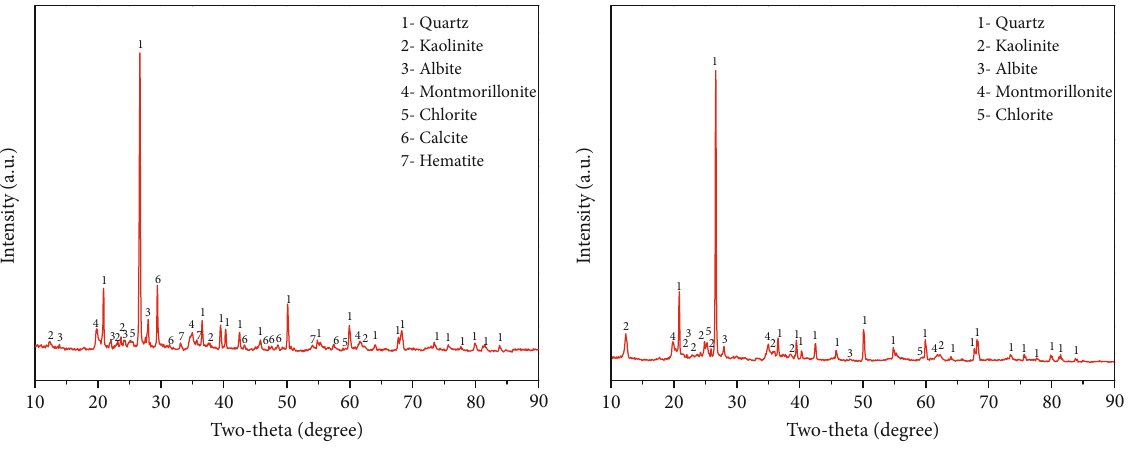
Figure 7: Resistivity part of CSAMT sounding inversion.